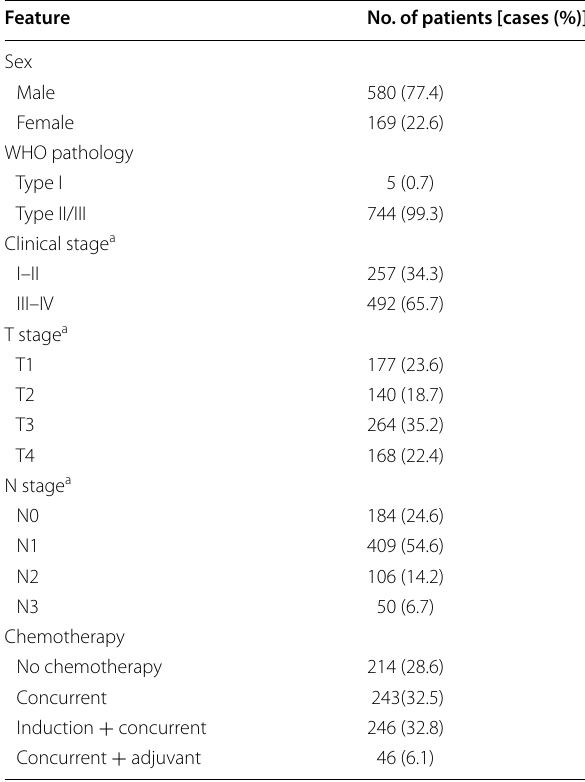
Table 1 Clinicopathologic features of the 749 patients with nasopharyngeal carcinoma (NPC)